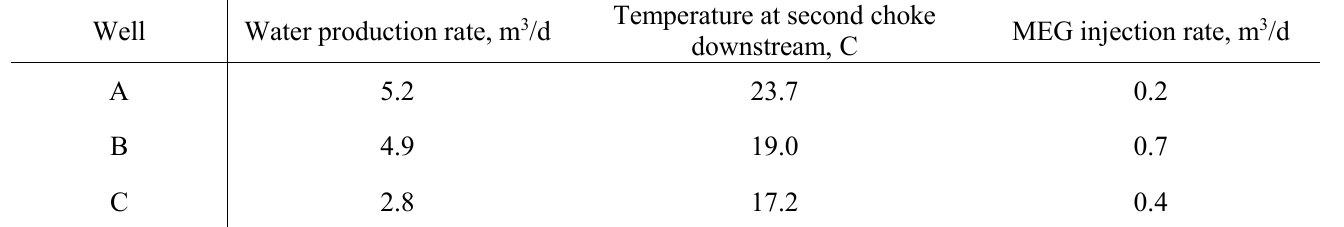
Table 2—Primary well data for hydrate management.